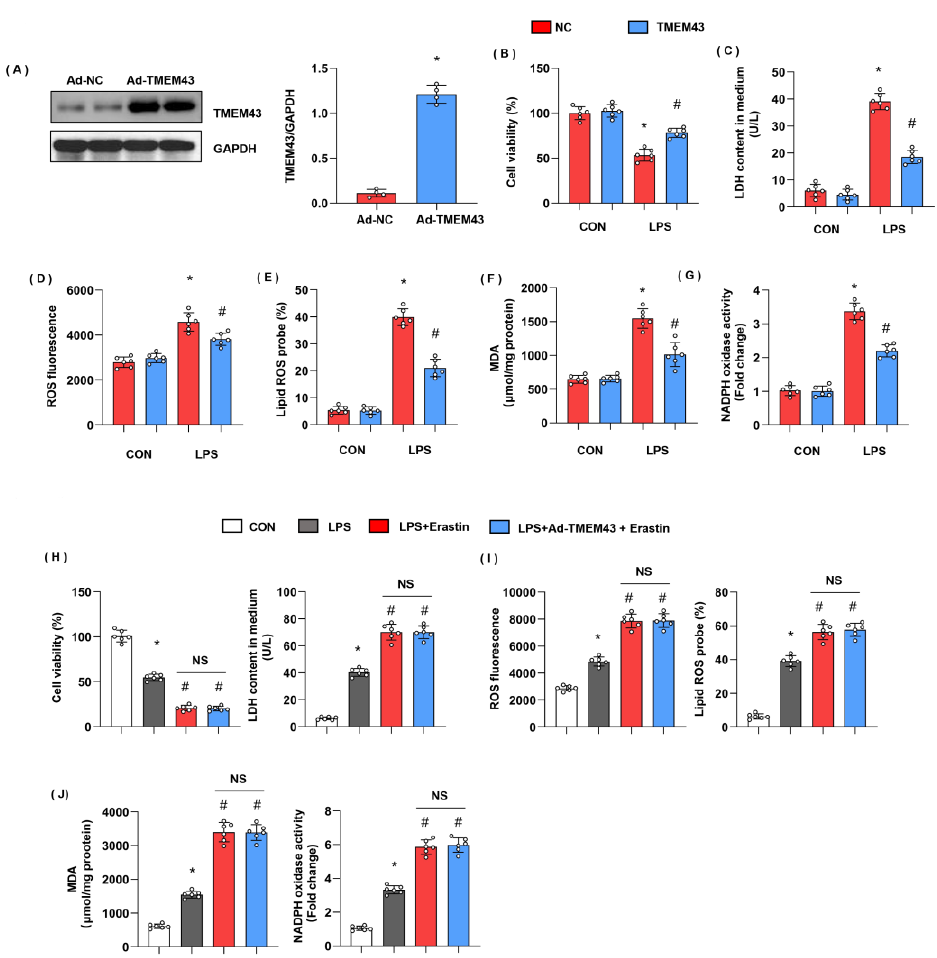
Figure 7. TMEM43 overexpression in vitro ameliorates LPS-induced cell injury. H9c2 cells were transfected with Ad-TMEM43. ( A ) Protein level of TMEM43 in H9c2 cells transfected with Ad-TMEM43 ( n = 4). ( B ) Cell viability in each group ( n = 6). ( C ) LDH level in H9c2 cells in each group ( n = 6). ( D ) ROS level in H9c2 cells in each group ( n = 6). ( E ) Lipid ROS level in H9c2 cells in each group ( n = 6). ( F , G ) MDA and NADPH oxidase activity in each group ( n = 6). * p < 0.05 vs. Ad-NC/CON group. # p < 0.05 vs. Ad-NC/LPS group. ( H – J ) H9c2 cells were transfected with Ad-TMEM43 and treated with erastin. ( H ) Cell viability and LDH level in H9c2 cells ( n = 6). ( I ) ROS level and lipid ROS level in H9c2 cells in each group ( n = 6). ( J ) MDA and NADPH oxidase activity in each group ( n = 6). * p < 0.05 vs. CON group. # p < 0.05 vs. LPS group.